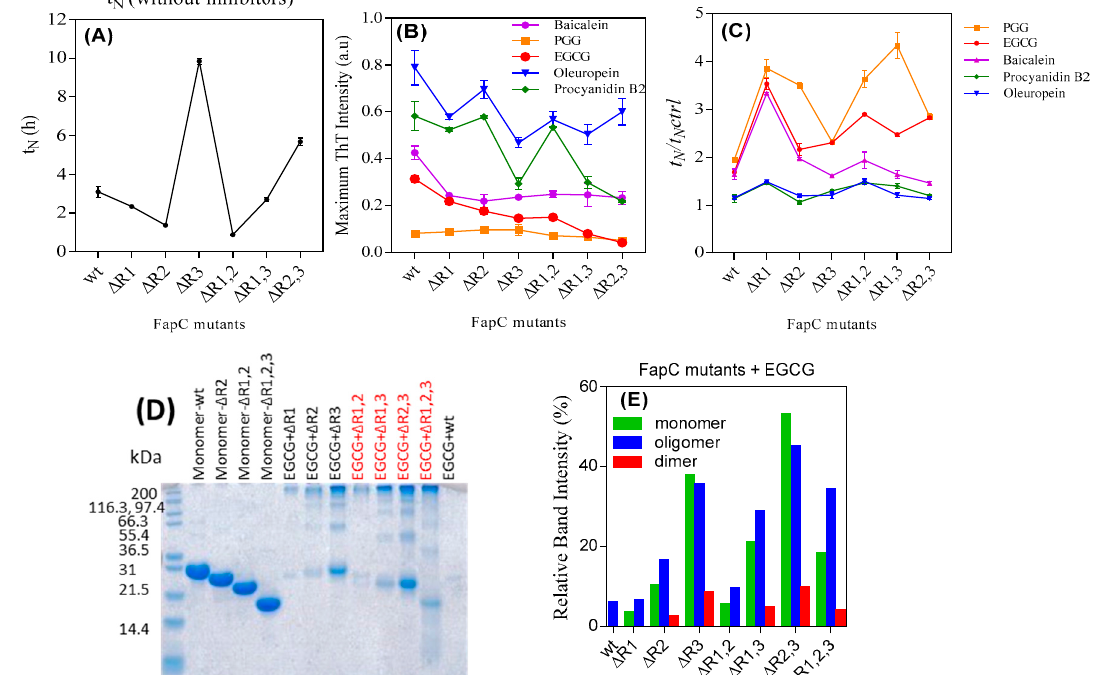
Figure 5. The inhibitory effect of polyphenols on the fibrillation of different FapC mutants. 30 µM of purified mutants of FapC-UK4 was incubated with 100 µM polyphenols in Tris buffer (pH 7.5) with shaking at 37 °C. ( A ) Absolute lag time (t N ) in the absence of polyphenols, ( B ) normalized maximum ThT emission of different mutants in the presence of inhibitors, ( C ) relative half time (t N /t N,control ); ( D ) SDS-PAGE of different mutants incubated with EGCG; ( E ) quantification of monomer, dimer, and oligomer bands from panel e using Image J.